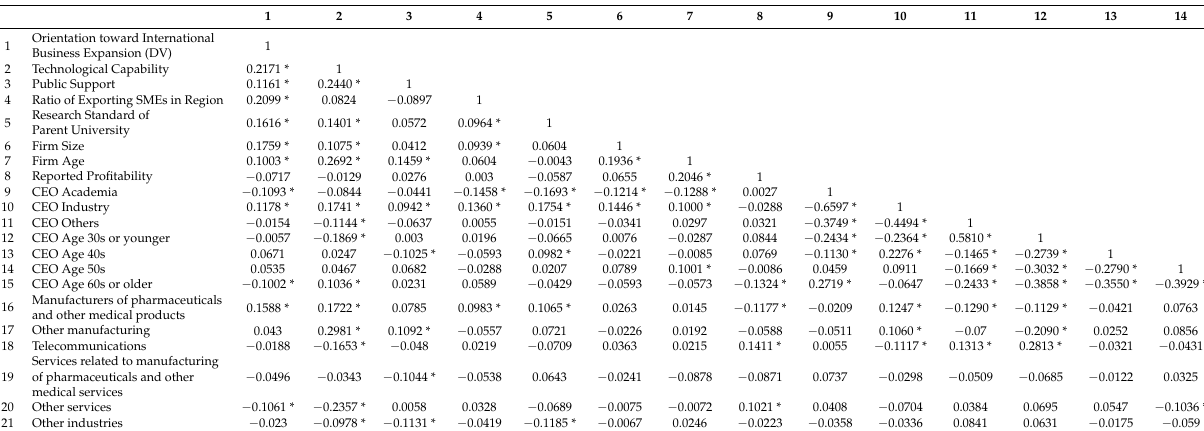
Table 2. Correlation